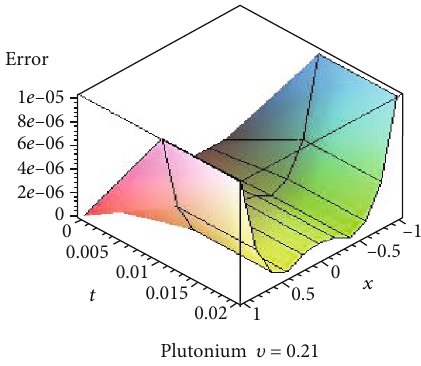
Figure 7: The value absolute error by PNM at N = 10 and T = 0 : 2 .